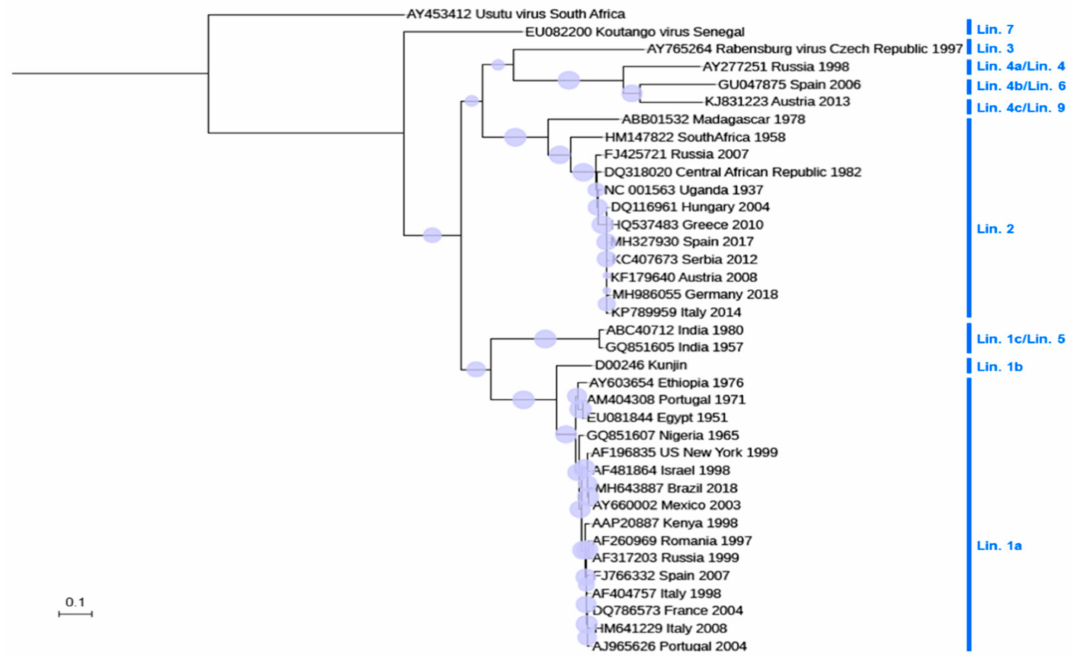
Figure 2. Phylogram, showing the relationships between the WNV strains. The tree is based on the complete nucleotide sequence of NS5 (except for HU2925 / 06 and MH327930). Multiple alignment was performed using MUSCLE [32], and a maximum likelihood tree was built using W-IQ-TREE [33]. The tree was visualized with iTOL [34]. Usutu virus was included as an outgroup for tree rooting. GenBank accession is indicated for each sequence. The country of origin and year of isolation is displayed when available. Circles size denotes the percentage of replicates in the bootstrap analysis (1000 bootstrap analyses). The scale indicates 0.1 substitutions / site. Phylogenetic lineages (Lin.) are indicated according to [5]. Genetic lineage 8 was not included in the tree because only partial sequence, not including NS5, is available